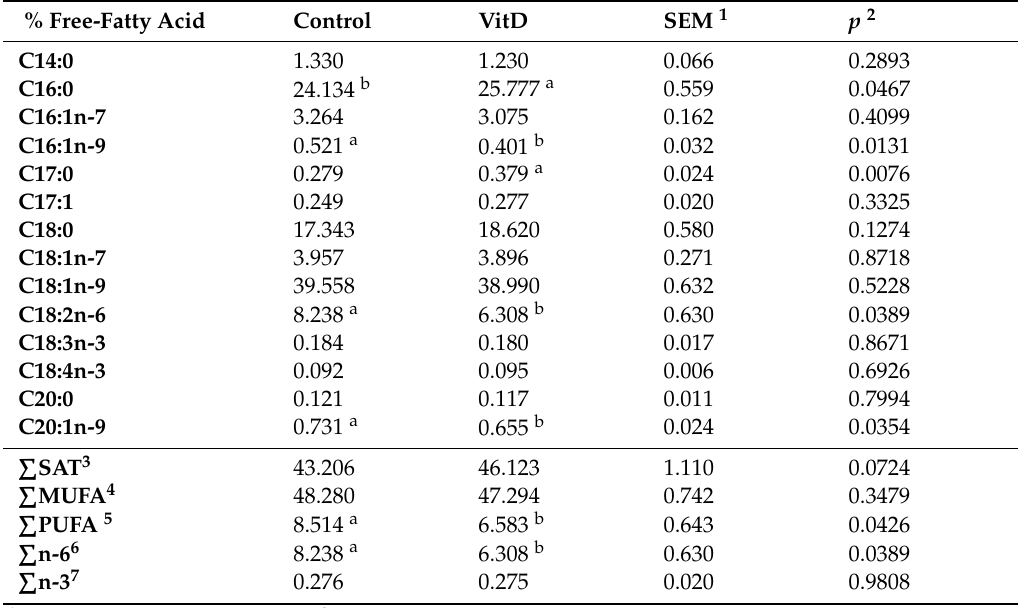
Table 2. Free-fatty acid proportion (g / 100 g fatty acids) in muscle from pigs supplemented with vitamin D 3 or without supplementation prior to slaughter (experiment